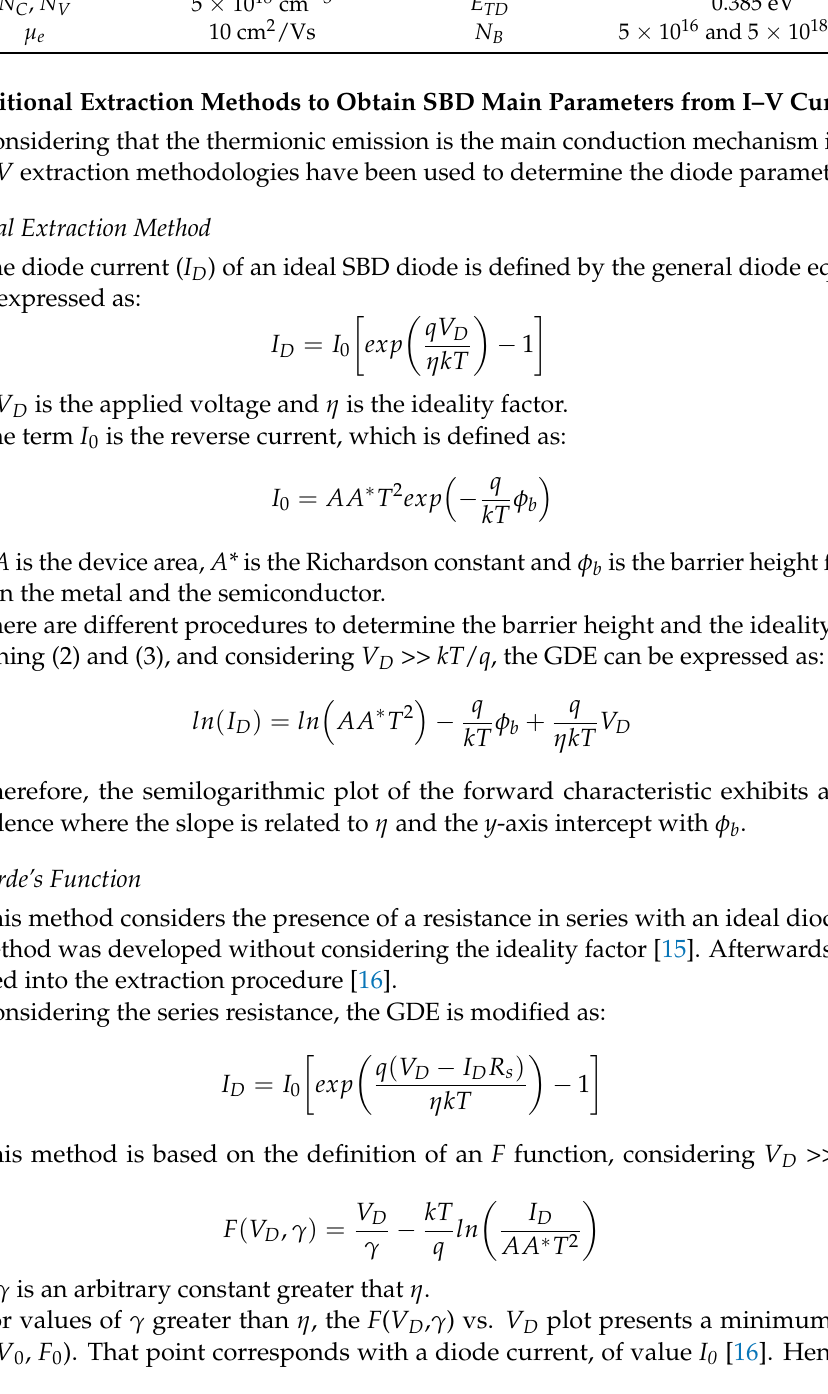
Table 1. Summary of the semiconductor film parameters used in simulations. Parameter Value Parameter Value E g 3.2 eV N TA , N TD χ s 4.3 eV 0.105 eV